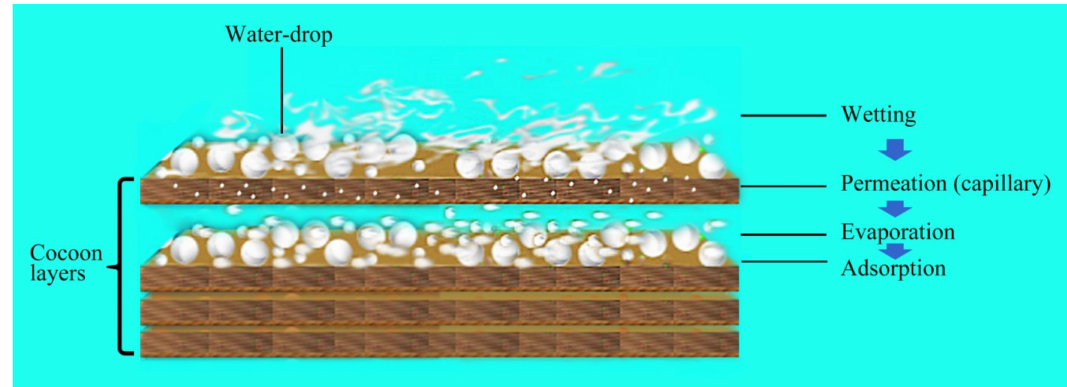
Figure 9. The multiple processes of moisture permeability of E cocoon.